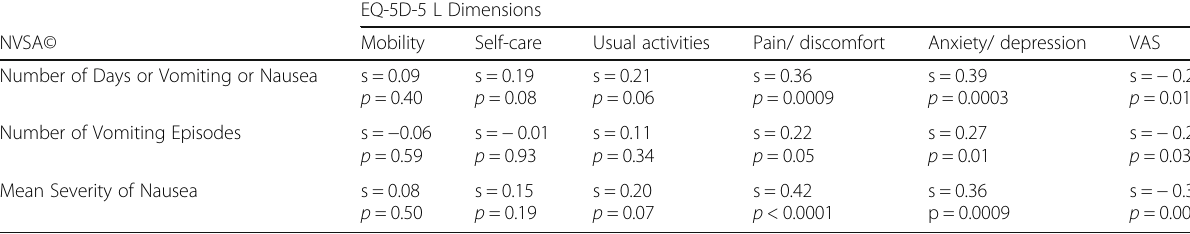
Table 5 Assessment of discriminant validity of NVSA © scores with the EQ-5D-5 L: Week 1